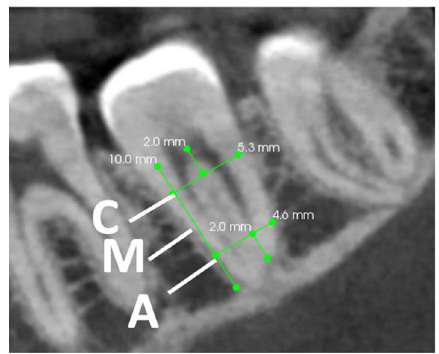
Figure 1. Representative sagittal CBCT view of a mandibular second molar generated by oblique slicing module. Exemplifying the three axial levels i.e., coronal (C), middle (M), and apical (A) at which the evaluation was